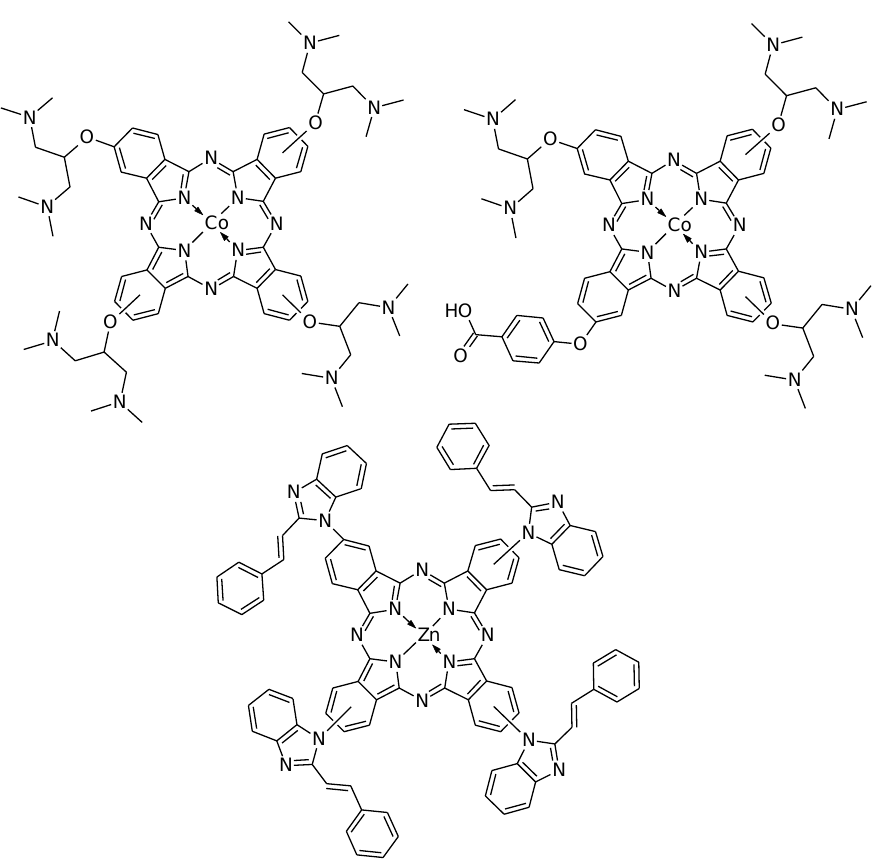
Figure 8. The chemical structures of symmetrical and unsymmetrical cobalt(II) and zinc(II) phthal- ocyanines investigated by Ndebele et al. and Pari et al.